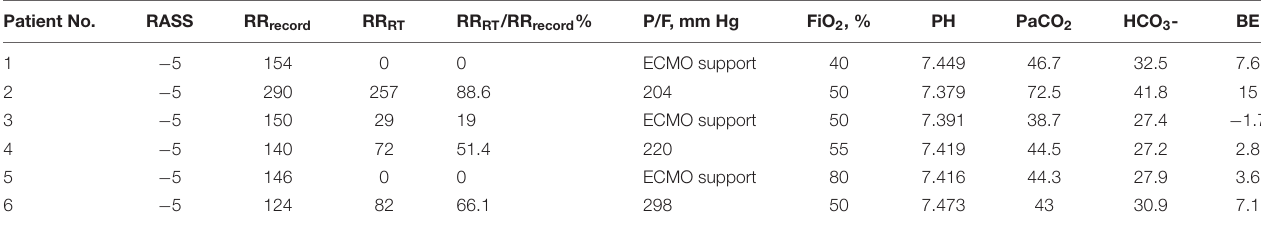
TABLE 2 | Patient’s sedation level, total recording respirations, reverse trigger duration and ratio, and arterial blood gases results. Patient No.